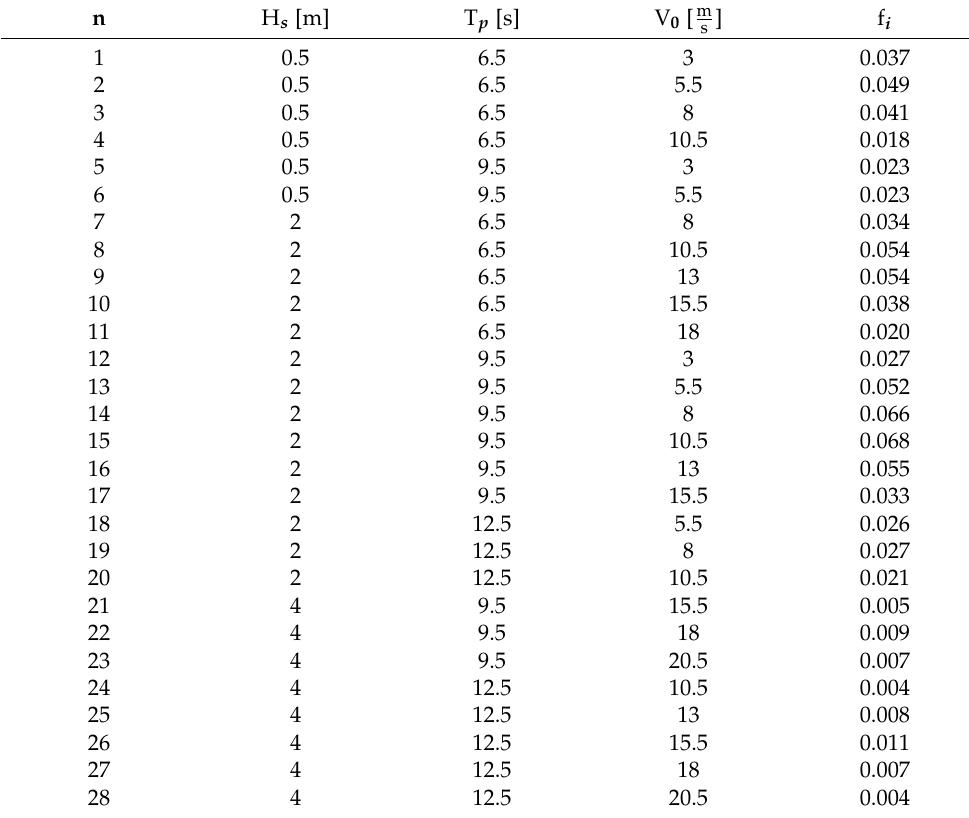
Table A1. List of triplet used to perform dynamic